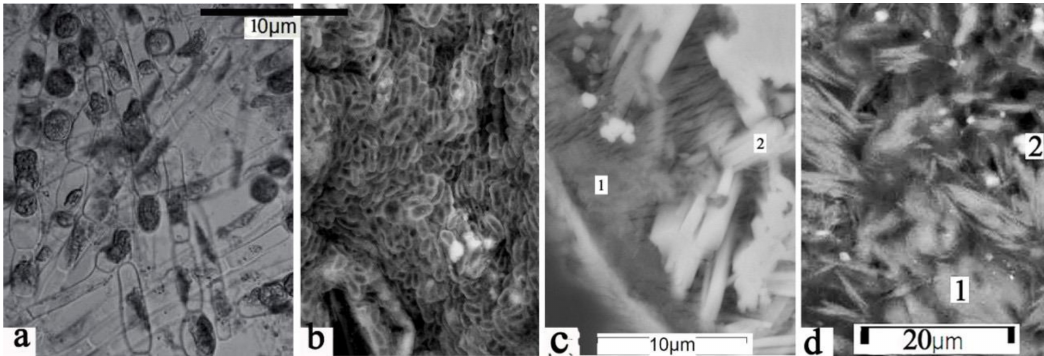
Figure 7. Microphotographs of authigenic minerals at the drifting biota–water and submerged biota–water borders: ( a ) Photo of Ctenocladus circinnatus Borz (Lake Petukhovo) [46]; ( b ) mineral films (Mg-sulfate) on the surface of the algobacterial colony (Lake Petukhovo); ( c ) mineral films (Mg-carbonate) on the surface of the algobacterial colony (Lake Urmannoe) and their replacement by carbonates: 1—MgCO 3 , 2—CaCO 3 ; ( d ) 1—MgCO 3 -substituted algobacterial colony (Lake Tanatar—6), 2—CaCO 3